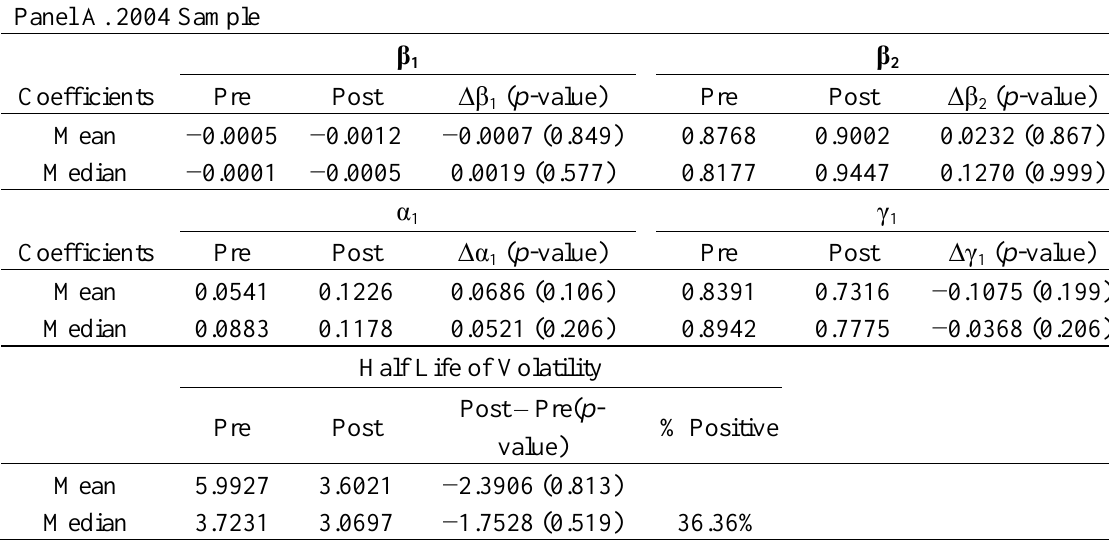
Table 7. Conditional Variance around MTU